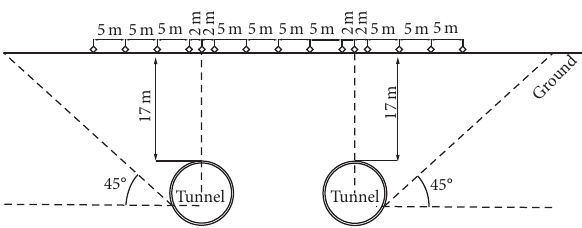
Figure 6: Transverse layout of ground subsidence monitoring points.